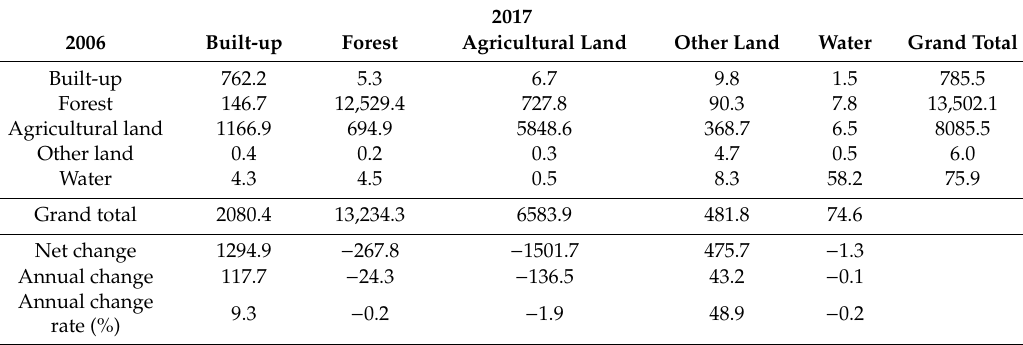
Table 7. Land use and land cover change matrix (ha),